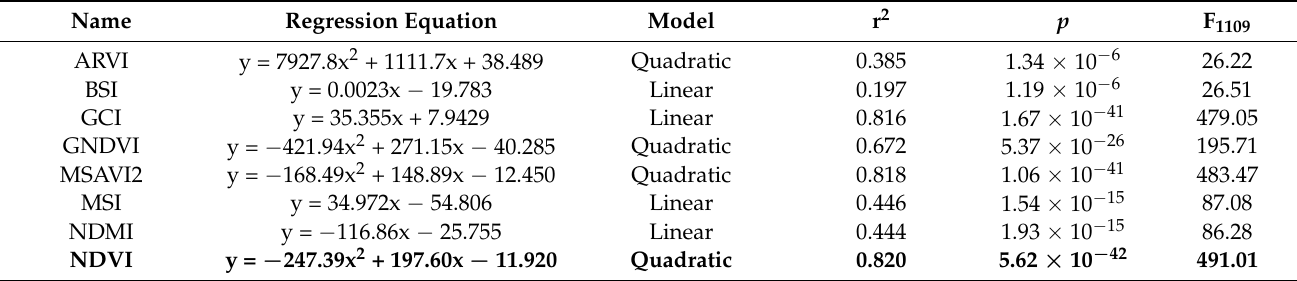
Table 3. Regression and test statistics of linear and quadratic regression analyses fitted to the Gi* z-score from the optimized hotspot analysis and the vegetation and soil moisture index